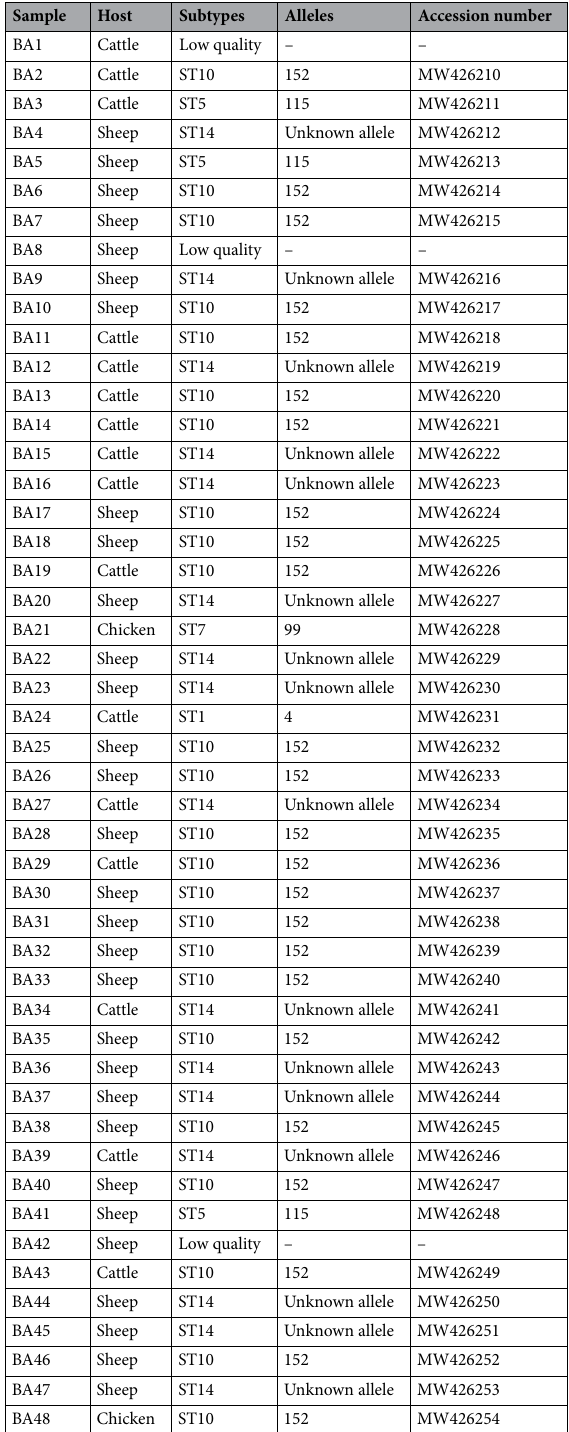
Table 5. Subtype and allele distribution and accession numbers of Blastocystis